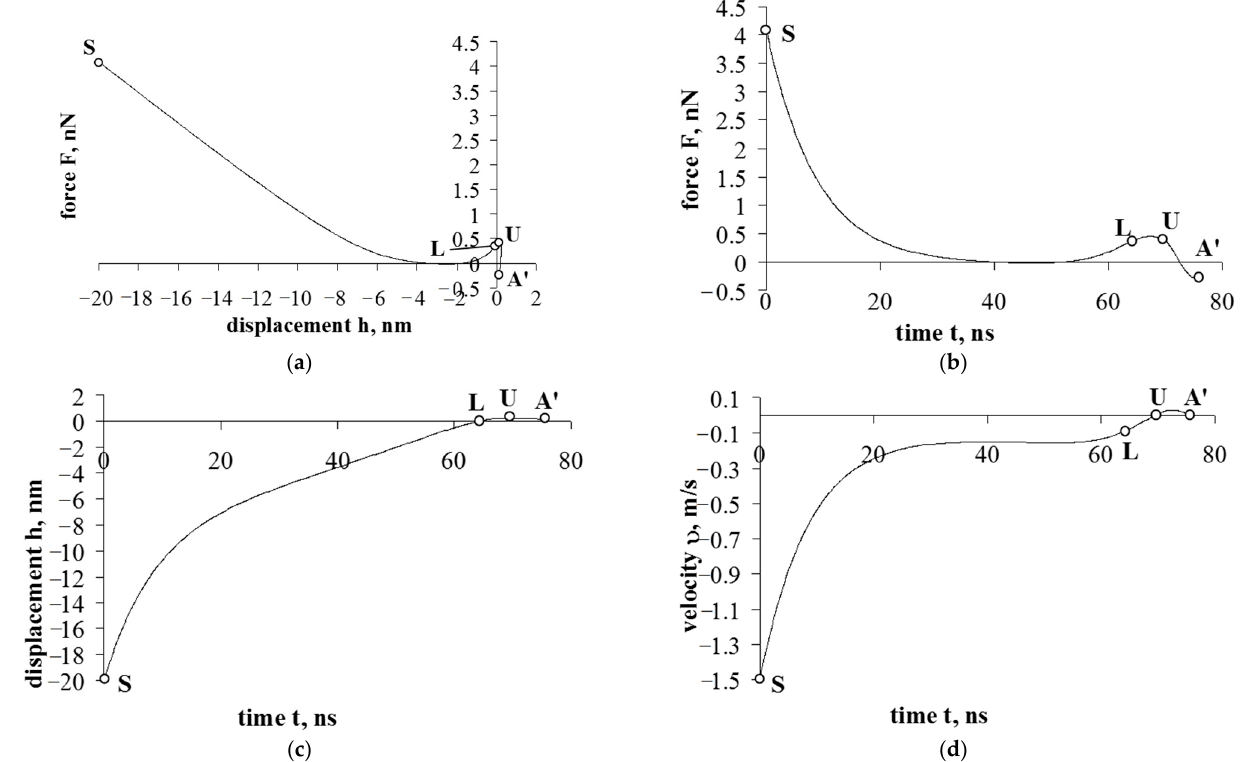
Figure 4. Particle interaction in alveolus. Particle diameter: 300 nm. ( a ) normal force F versus dis-